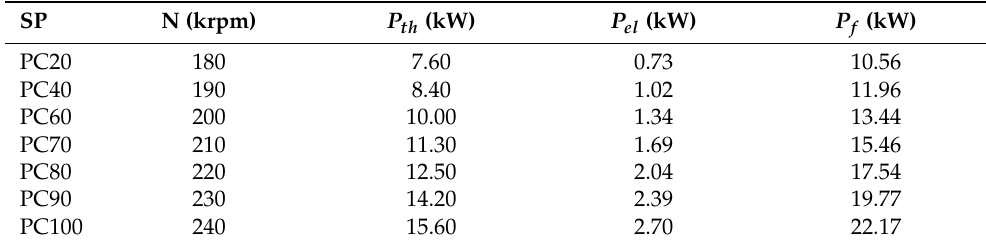
Table 1. Steady state properties at various setting points. N = rotational speed, P th = thermal power, P el = electrical power, and P f = fuel